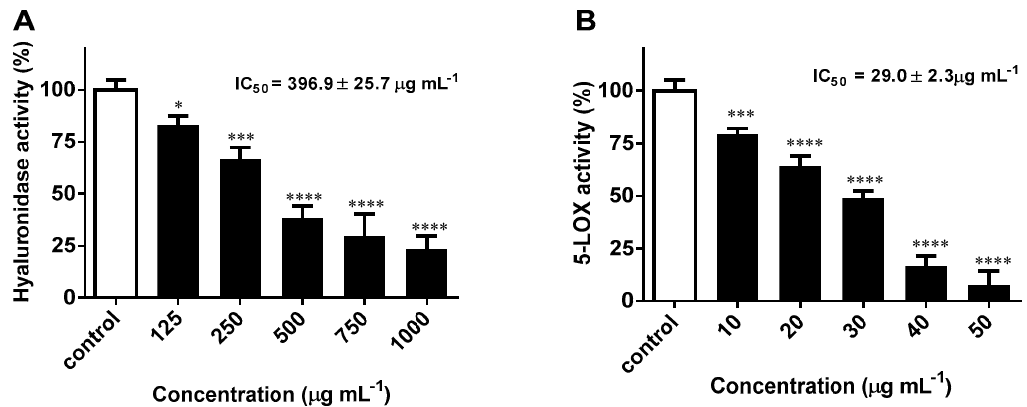
Figure 2. Inhibitory effects towards hyaluronidase ( A ) and 5-lipoxygenase ( B ) activity upon exposure to H. bhamoense trunk bark methanol extract. The results correspond to the mean ± SEM of three independent experiments performed in triplicate (statistical significance: * p < 0.05, *** p < 0.001 and **** p < 0.0001).